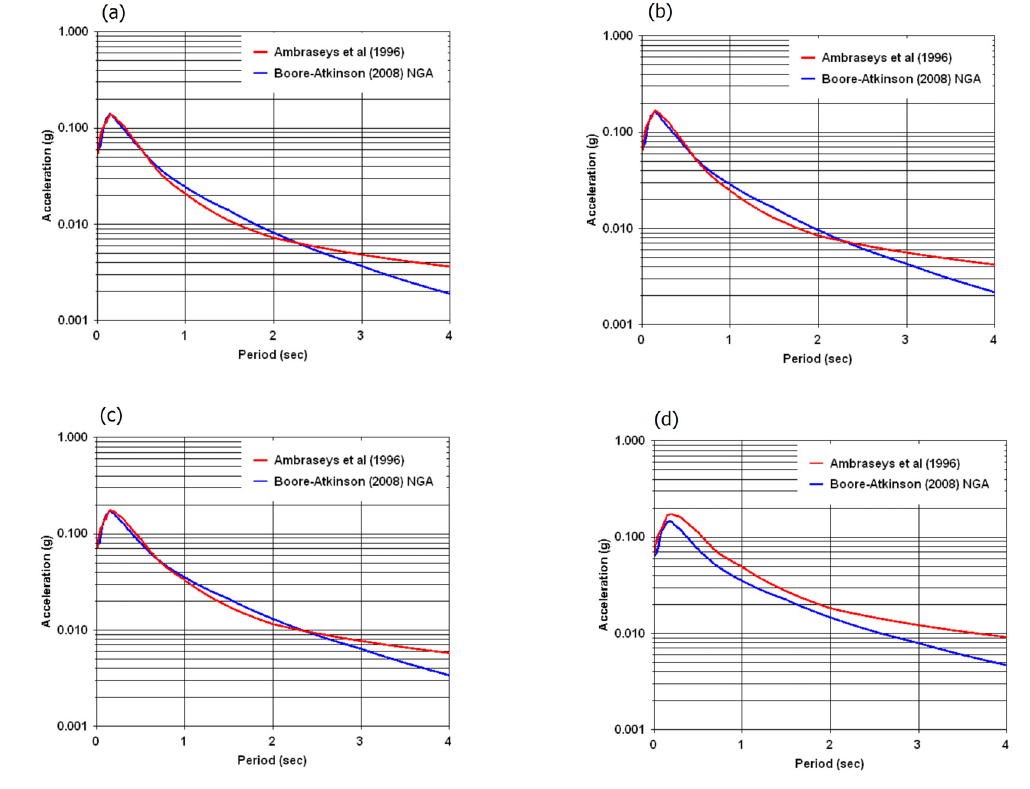
Figure 10. Spectral accelerations for earthquake scenarios in Kermanshah; (a) =4.8 at =22 km for Sa (0.01 s) and MRP of 50-year, (b) =5.7 at =42 km for Sa (0.01 s) and MRP of 475 yr, (c) =4.9 at =21 km for Sa (2 s) and MRP of 50 yr, (d) =6.1 at =45 km for Sa (2 s) and MRP of 475-year.